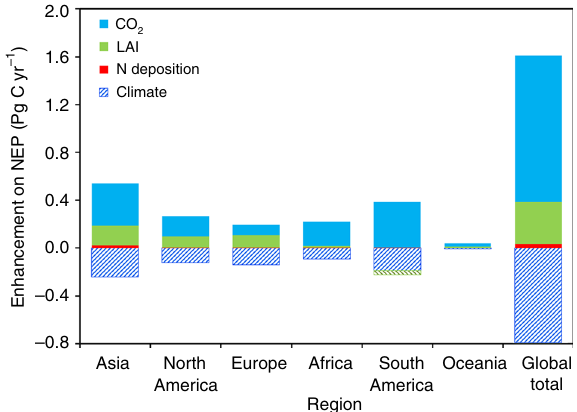
Fig. 4 Attribution of the global land sink to various factors by region averaged over the period from 1981 to 2016. The values shown are regional and global totals of mean land sinks simulated with an individual diver (CO 2 , LAI, nitrogen deposition, and climate) changing historically and other factors being remained temporally unchanged minus the lase sinks due